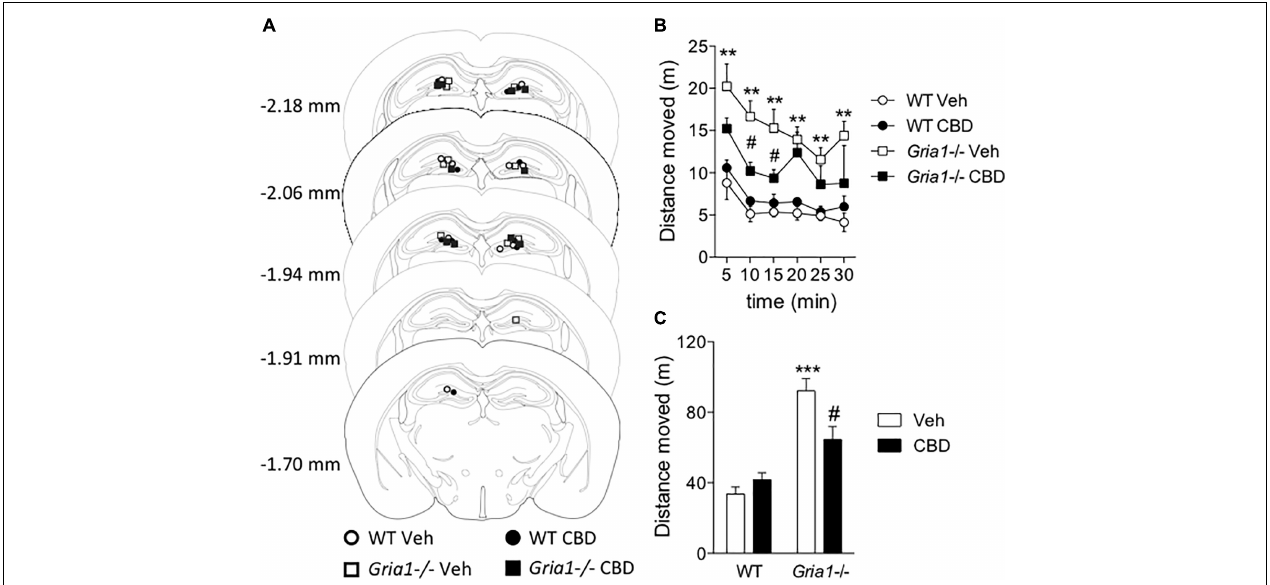
FIGURE 3 | Intrahippocampal infusion of cannabidiol decreases novelty-induced hyperlocomotion of Gria1 − / − mice. Animals were given an infusion with vehicle or cannabidiol (5 µ g/side) followed by recording of distance moved for 30 min. (A) Injector tip placements within the dorsal hippocampus for all experimental groups. The brain images were modified with permission from Paxinos and Franklin (2001). (B) Distance traveled in a novel environment in 5-min periods. (C) Total distance traveled during 30-min trials. ∗∗ P < 0.01 and ∗∗∗ P < 0.001 for the significances of the differences between the genotypes after vehicle; # P < 0.05 between vehicle and CBD within the same genotype (Bonferroni post-test). N = 10 for both genotypes. Veh, vehicle; CBD, cannabidiol.